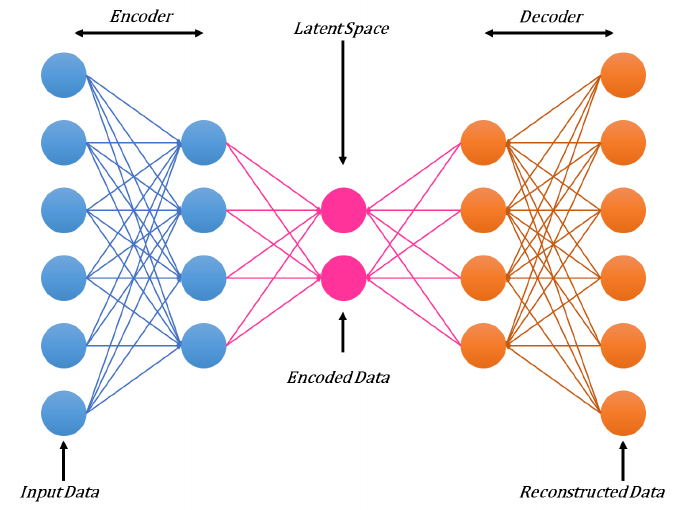
Figure 7. A general architecture of an Autoencoder